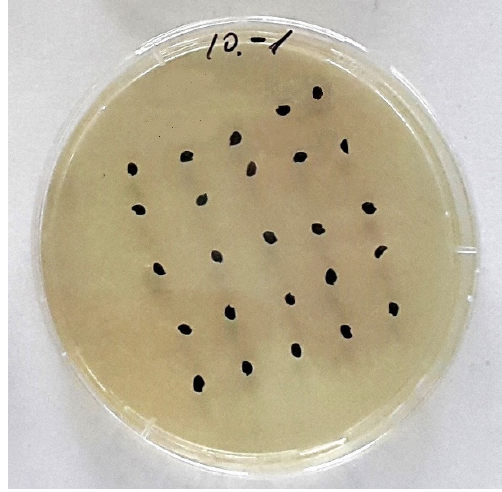
Figure 1. Arrangement of 25 seeds.